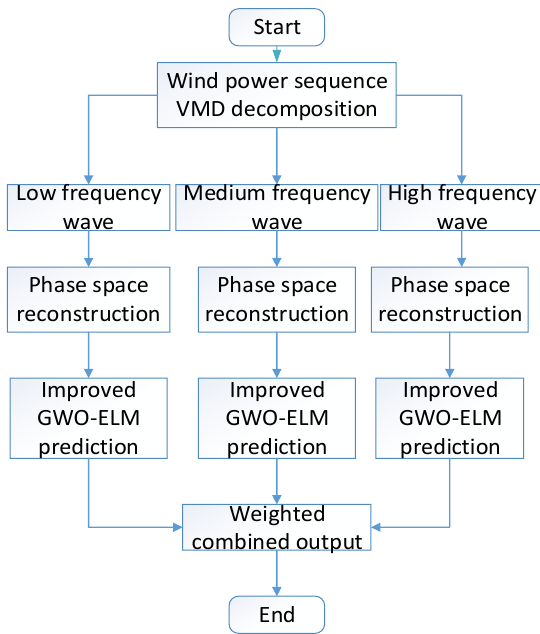
Figure 2. Short-term wind power prediction flow chart based on improved grey wolf optimization (GWO)- extreme learning machine (ELM) model.